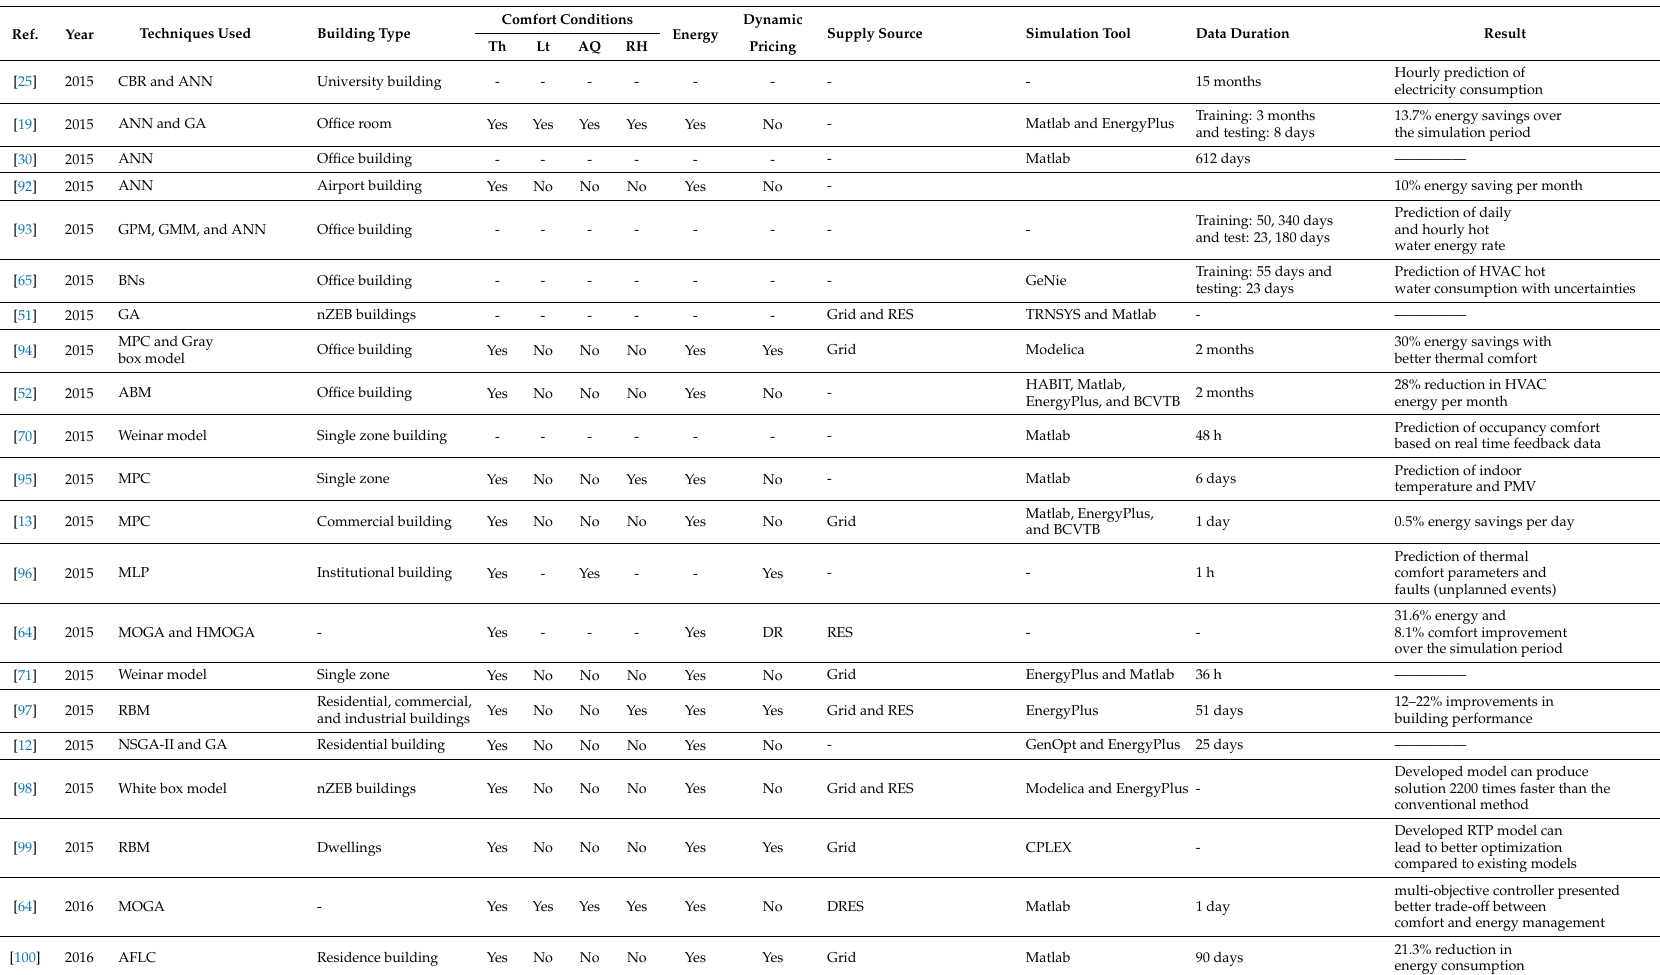
ModelicaandEnergyPlus